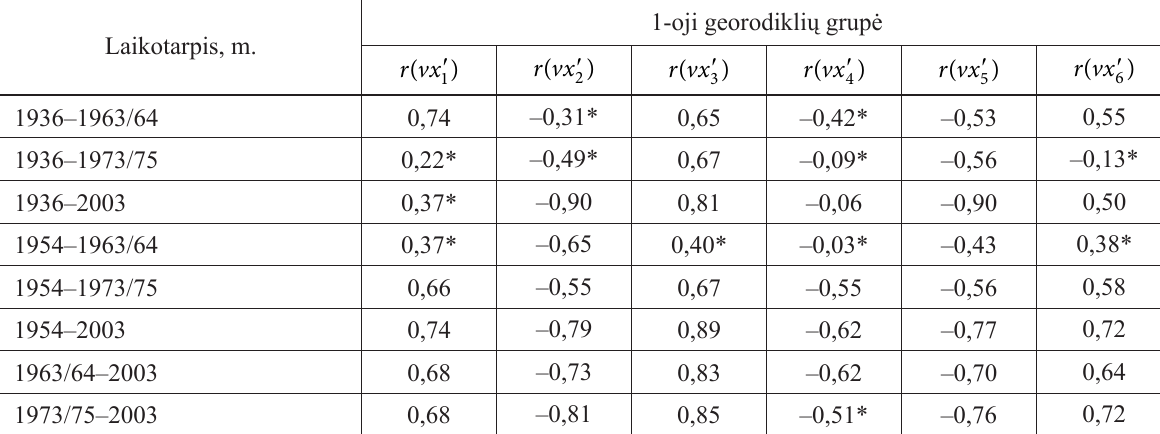
Table 1. Velocity correlations of the vertical movements of the Earth’s crust with geoindexes for the first group Laikotarpis,